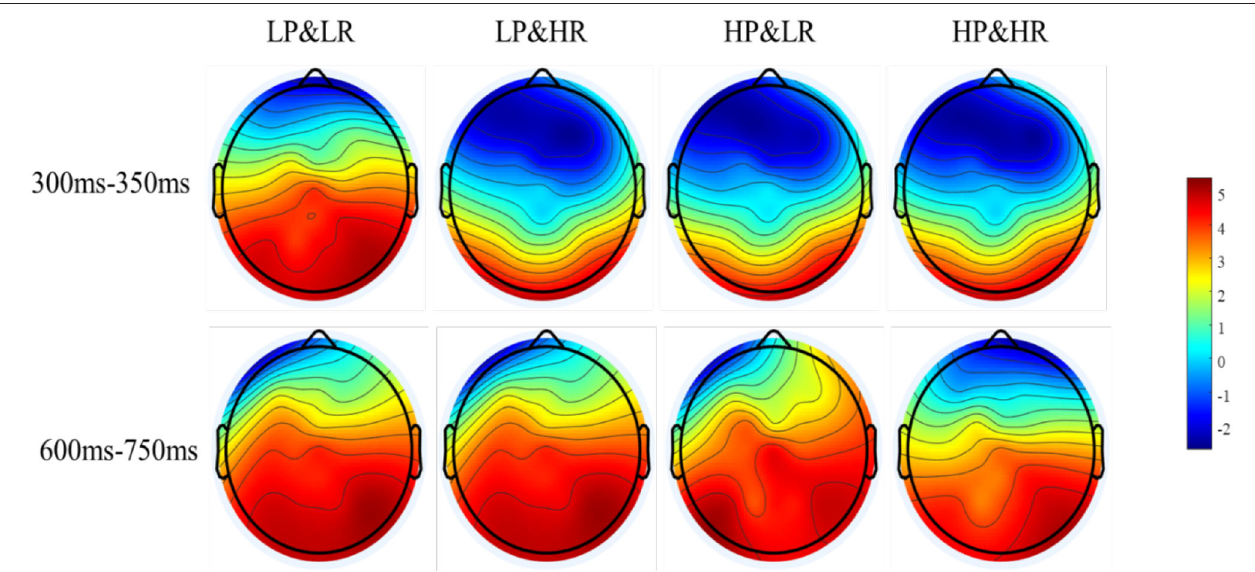
FIGURE 9 | Brain voltage maps of N2 and LPP under different